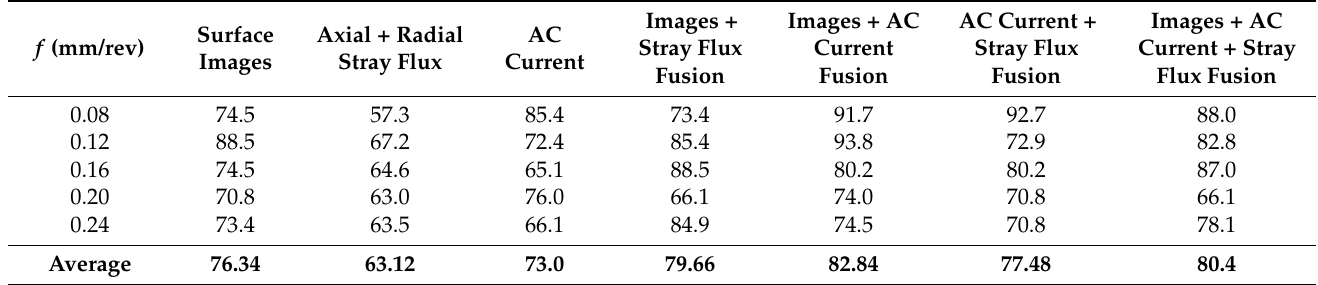
Table 7. Effectiveness results for the classification of tool wear with the use of the FFNN for the tool feed rate tests.